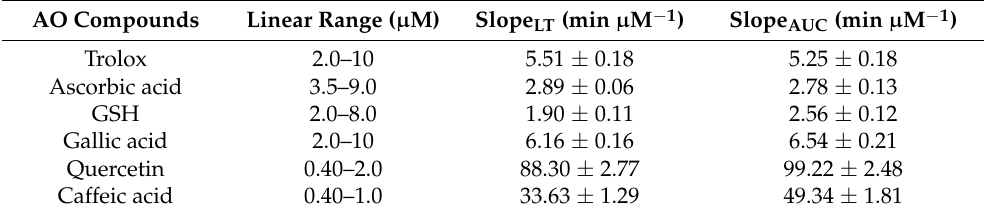
Table 1. Slope of calibration curves a established using lag time (LT) and area under curve (AUC) vs. antioxidant (AO) concentration.